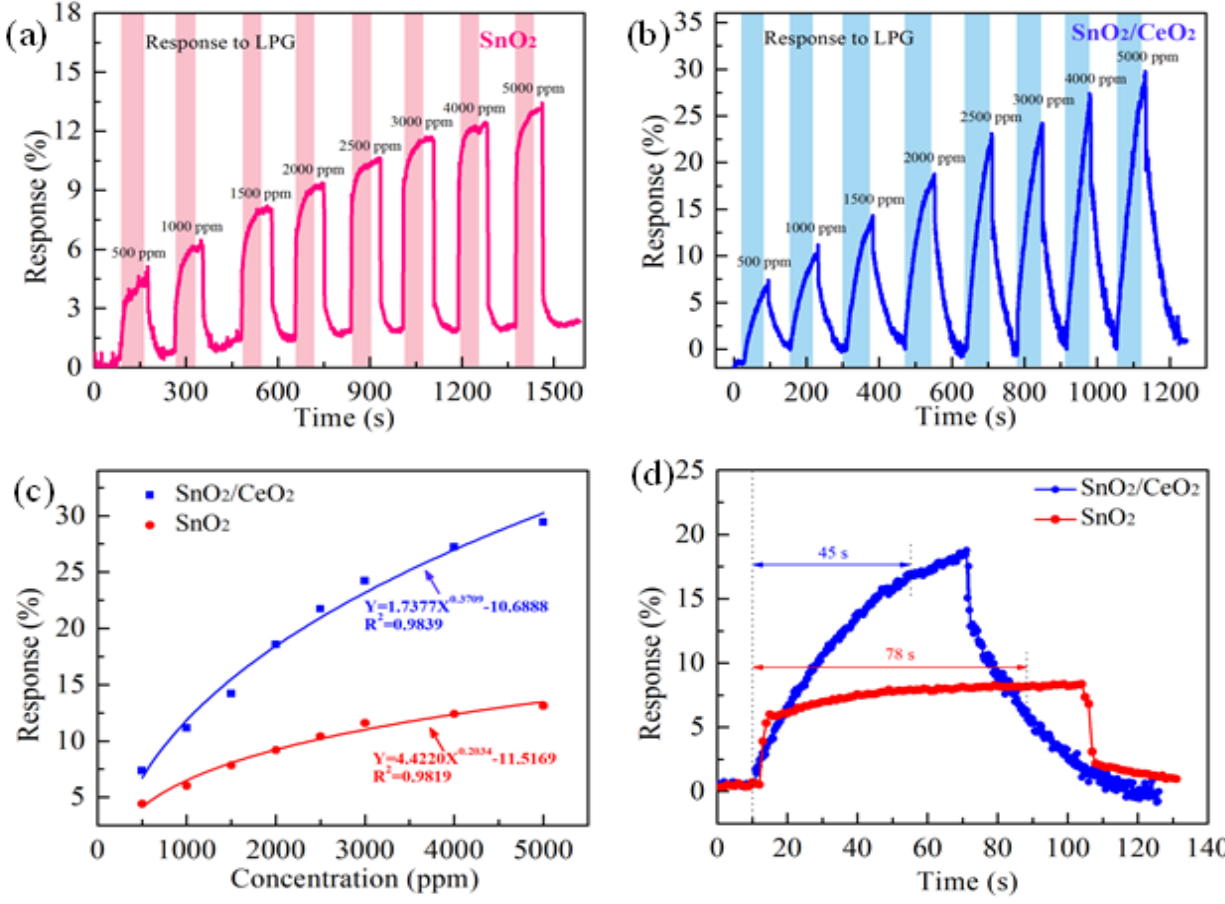
Figure 5 . Responses of sensors based on ( a ) pure SnO 2 and ( b ) SnO 2 /CeO 2 nanocomposite versus LPG concentration in the range of 500 – 5000 ppm. ( c ) Response vs. concentration of LPG. ( d ) Single transient response of pure SnO 2 and SnO 2 /CeO 2 nanocomposite.